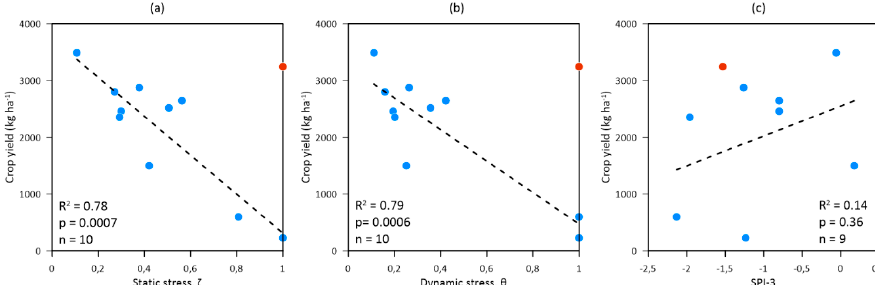
Figure 8. Prediction of crop yield as a function of different drought indicators: ( a ) static stress, ( b ) dynamic stress and ( c ) Standardized Precipitation Index (SPI)-3. Note that the red dots indicate outliers that were not taken into account; see text for details.